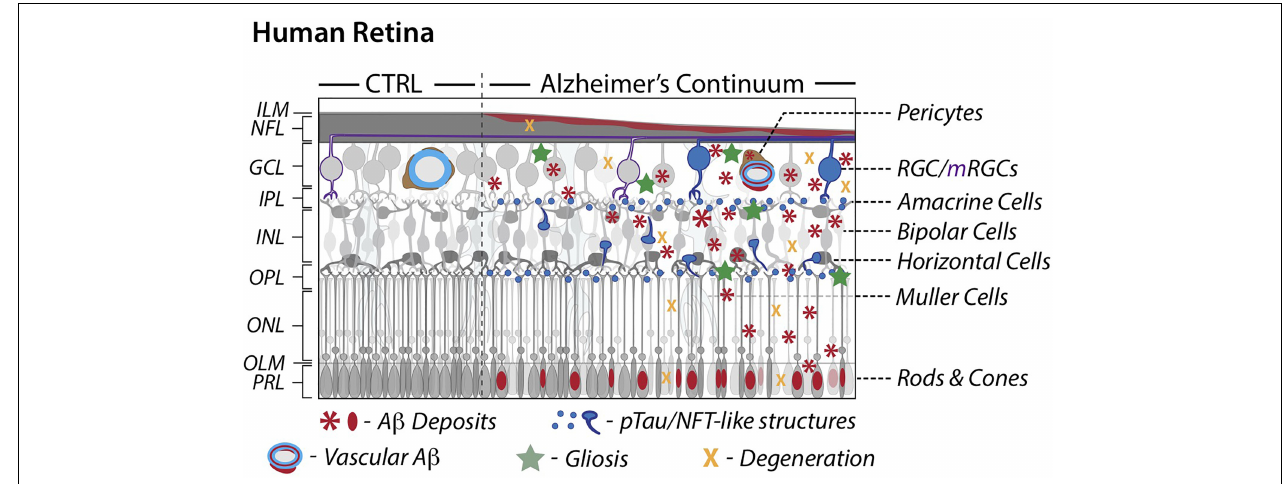
FIGURE 1 | Schematic illustration of retinal pathology in AD patients. A comparison between cognitively normal control and AD retinas along a continuum. AD attributed retinal pathology includes accumulation of A β and phosphorylated-tau proteins, degeneration and subsequent thinning, and an inflammatory response. AD retinal vessels display substantial thinning and pericyte loss alongside A β protein deposition. Modified illustration from Advances in Retinal Imaging: Retinal Amyloid Imaging (Koronyo-Hamaoui et al., 2020) with permission from Springer Nature via Copyright Clearance Center. A β , Amyloid- β protein; CTRL, control; GCL, ganglion cell layer; ILM, inner limiting membrane; INL, inner nuclear layer; IPL, inner plexiform layer; mRGCs, melanopsin-containing retinal ganglion cells; NFL, nerve fiber layer; NFT, neurofibrillary tangles; OPL, outer plexiform layer; ONL, outer nuclear layer; OLM, outer limiting membrane; PRL, photoreceptor layer; RGCs, retinal ganglion cells; pTau, hyperphosphorylated tau.